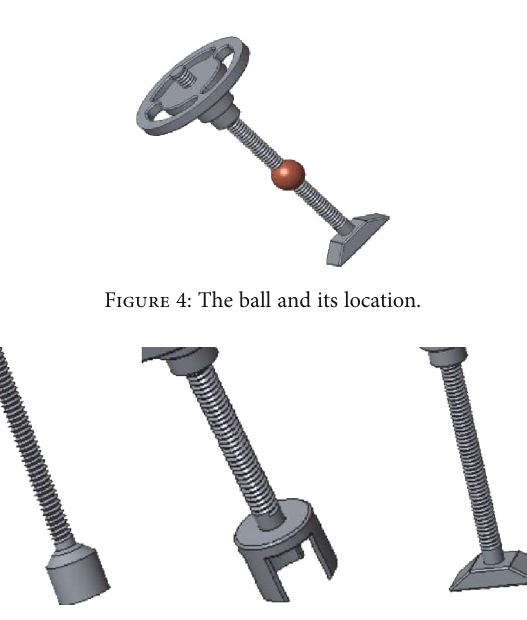
Figure 1: Schematic diagram of the middle ear. (a) The prosthetic replacement for the lack of middle ear stapes and incus. (b) The prosthetic replacement for the lack of middle ear incus.